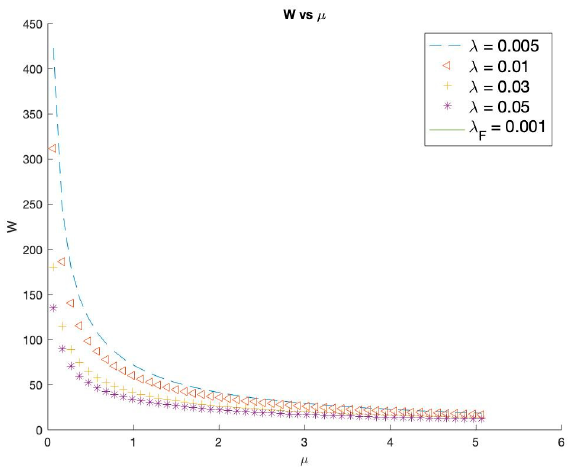
Figure 6. Average amount of time in system ( W ) vs rate of slots ( µ ). Figure 7 plots (cid:1849) (cid:3018) versus (cid:1866) , for various λ and a (cid:2020) (at 1/15).